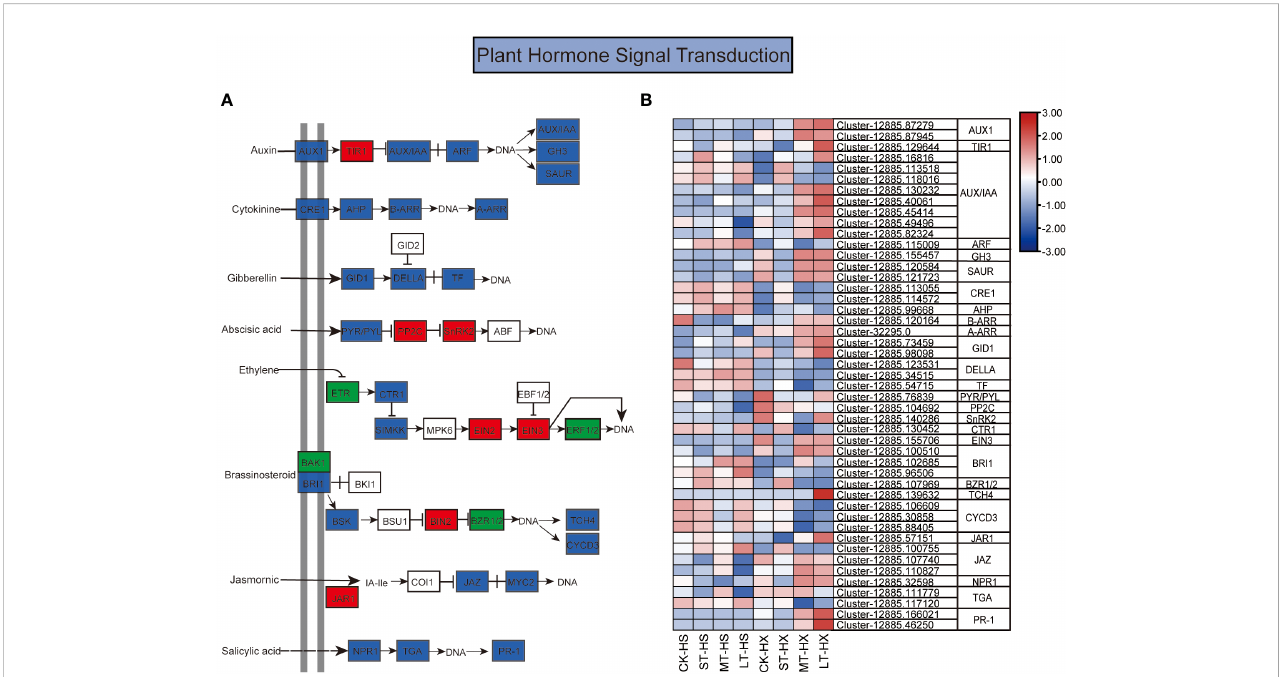
FIGURE 6 The KEGG pathway annotation diagram of the plant hormone signal transduction pathway of DEGs. (A) Schematic diagram of the KEGG pathway for the enrichment of DEGs in the plant hormone signal transduction pathway. Red boxes indicate upregulation, green boxes indicate downregulation, and blue boxes indicate both up- and downregulation. (B) Heatmap showing the expression of DEGs associated with different hormones. Box color indicates the expression level of each gene: blue = decreased expression and red = increased